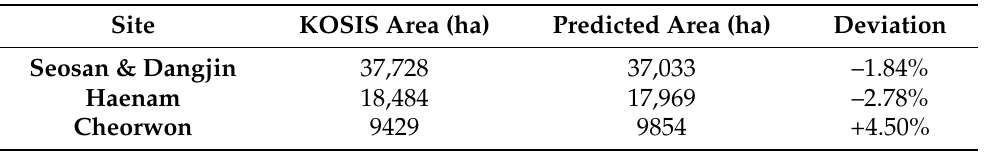
Table 3. Paddy rice area for the Seosan-Dangjin, Haenam and Cheorwon sites from the official Korean Statistical Information Service (KOSIS) compared to the total paddy rice area predicted by this study’s model (using images until July).